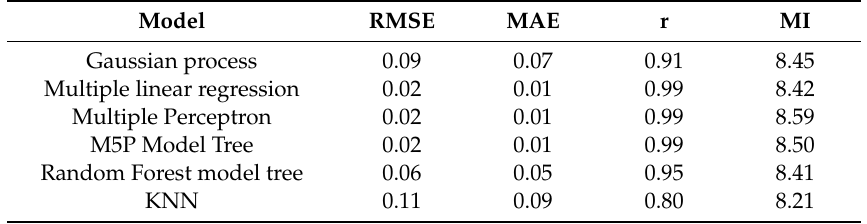
Table 7. Summary of performance of multiple ML models with training data from 2007 to 2012.